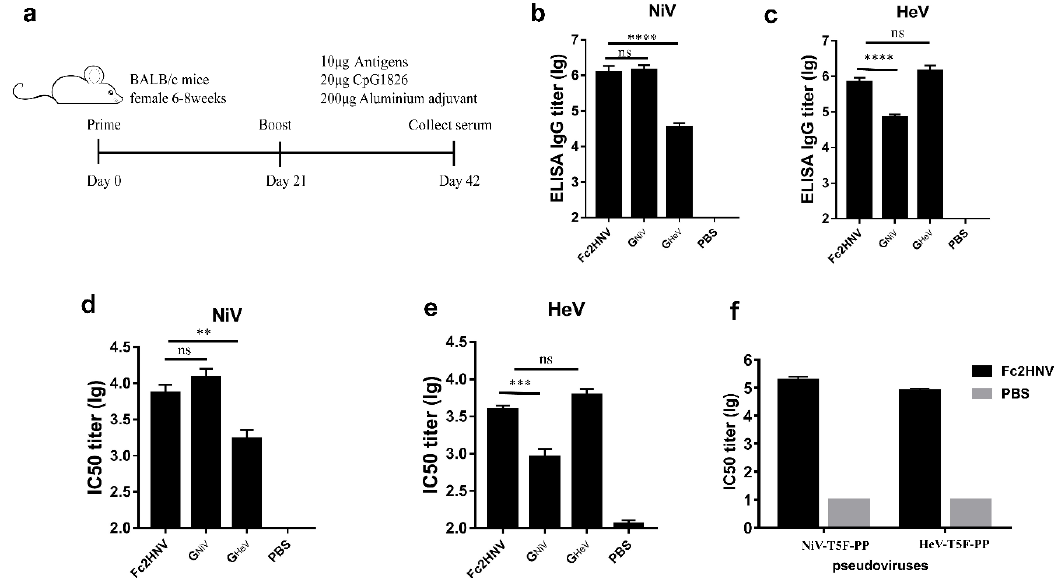
Figure 6. Specific antibodies and neutralizing antibody responses stimulated by Fc2HNV. ( a ) BALB/c mice (6–8 weeks, female, N = 6 per group) were immunized intramuscularly with 10 μ g G NiV , G HeV or Fc2HNV at week 0 and 3. The adjuvants added were 200 μ g of aluminum hydroxide and 20 μ g of CpG1826. A group of mice were injected with PBS as a control group. At 42 days after immunization, the mice were sacrificed and the serum was collected. Specific antibodies against G NiV ( b ) and G HeV ( c ) in the serum were tested by an enzyme-linked immunosorbent assay. Neutralizing antibody titers against NiV ( d ) or HeV ( e ) were detected by a multiplex microsphere ephrinB2 inhibition assay. ( f ) The NiV and HeV pseudovirus neutralization experiment. The mean log10 ELISA titers and mean log10 IC50 titers ±SEM are shown. Student’s t test was performed for all comparisons, and a P -value < 0.05 was considered statistically significant; ** 0.001< P -value < 0.01; *** 0.0001< P -value < 0.001; **** P -value < 0.0001.